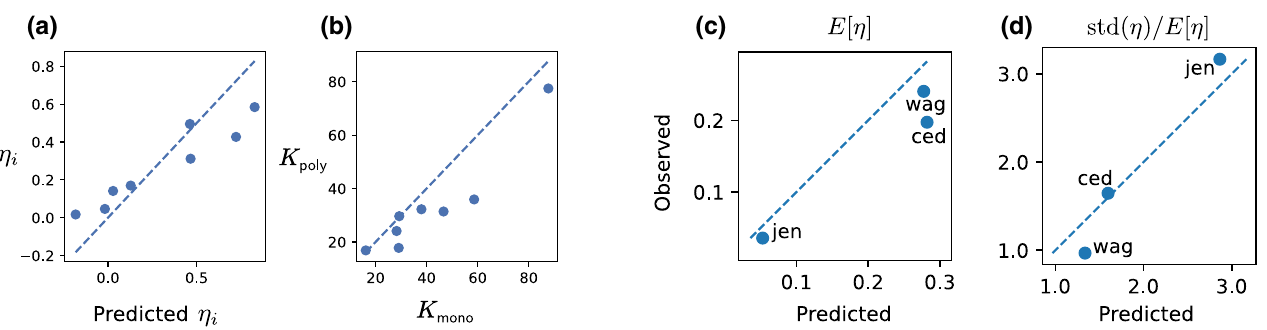
FIG. 4. Validation of the Lotka-Volterra model. The consistency of the equilibrium description (2) was validated through a series of tests. For the Wageningen grassland experiment (with S ¼ 8 species), we find accurate predictions for the full fitted Lotka-Volterra model (dashed lines show a 1 ∶ 1 relationship between prediction and measurement). (a) We compare the equilibrium values of η B =K in the full-diversity plot ( S ¼ 8 ) to the prediction η i i compositions (plots with S < 8 ). (b) Carrying capacities K ( S > 1 ) agree with direct measurements in monocultures ( S ¼ 1 ). (c),(d) Even when species are too numerous to allow a precise inference of all pairwise interactions, we can predict statistics of η pairs, following the methodology in Ref. [23]. Across the Wageningen, Cedar Creek Big Bio (16 species), and Jena (60 species) experiments, we find good agreement in predicted versus measured values for the mean in (c) and coefficient of variation in (d) of relative yields in the full-diversity